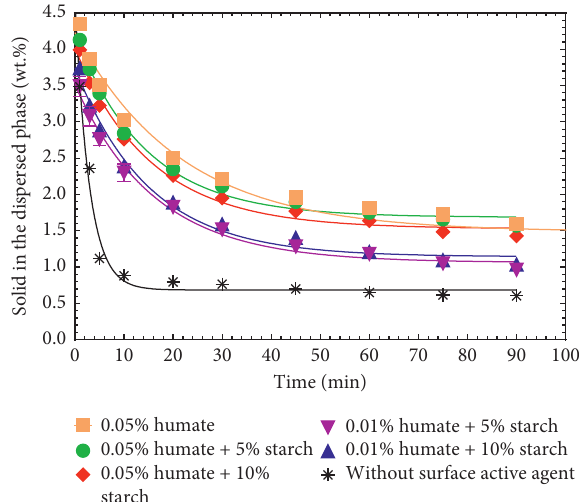
2 O 3 /Fe and Al 2 O 3 /SiO 2 Figure 5: Stability of suspension in 10 wt. % slurry of iron ore fines at pH 8.